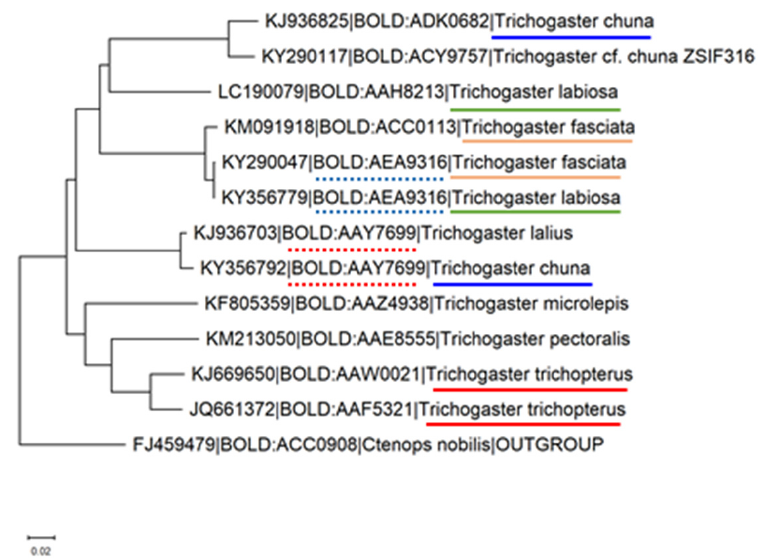
Figure 24. Phylogenetic tree of the COI-5p gene records of the genus Trichogaster. Twelve nucleotide sequences from 8 species were retrieved from BoldSystem [46], such that every species is represented by sequences from unique bins. Tree was constructed using Neighbour-joining method using Kimura 2 Distance Model, with pairwise deletion and MUSCLE alignment in the MEGA-X software [47]. A sequence from the genus Ctenops was used as an outgroup. Leaves are marked with genbank_accession|Bold_bin_id|species. Sequences that belong to the species that appear more than once in the tree are underlined with the same color. Bins that appear more than once are underlined with a dotted line.